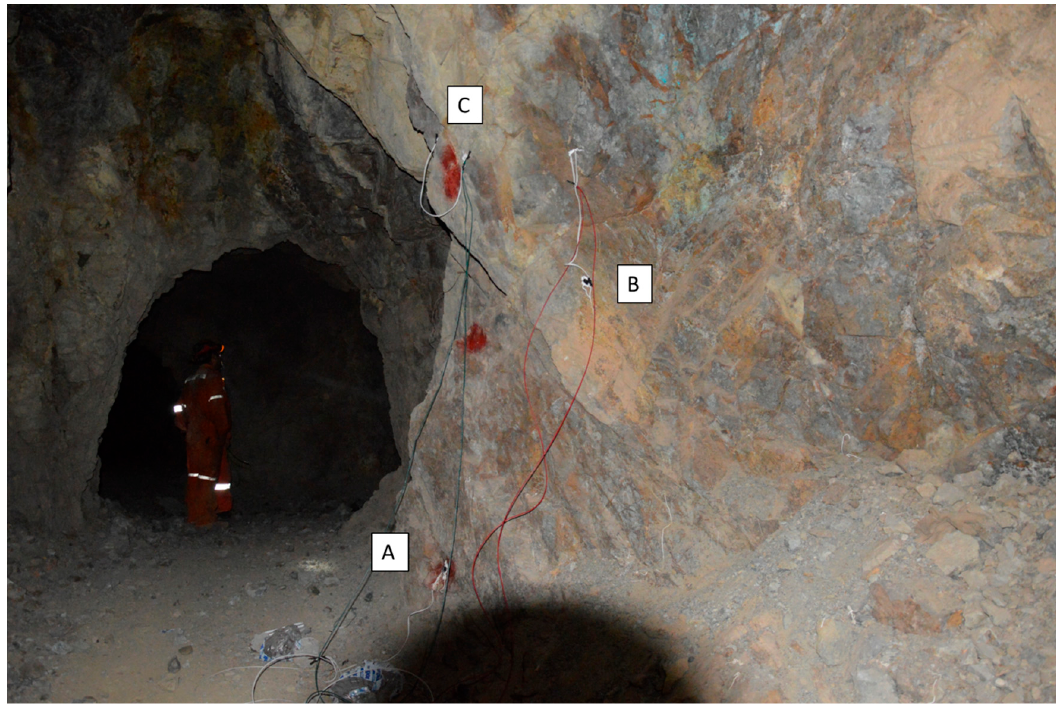
Figure 4. Installation of the sensors on the tunnel walls. Each sensor lay on a joint belonging to a different set of discontinuities.